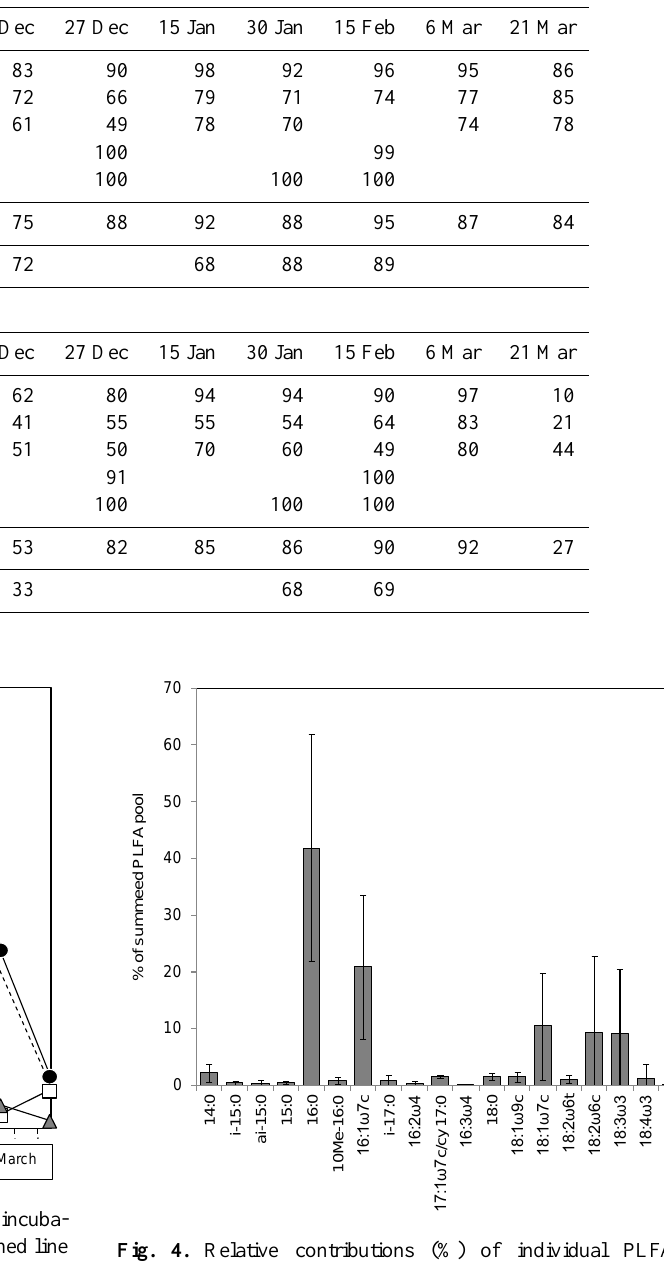
Table 2. Inhibition of 13 C-DIC fixation in PLFAs and crenarchaeol by nitrapyrin and chlorate. Inhibition (%) was calculated as: ((( 13 C fixa- tion without inhibitor) – ( 13 C fixation with inhibitor))/( 13 C fixation without inhibitor)) × 100. Missing values correspond to concentrations and/or 13 C enrichment below limit of detection.